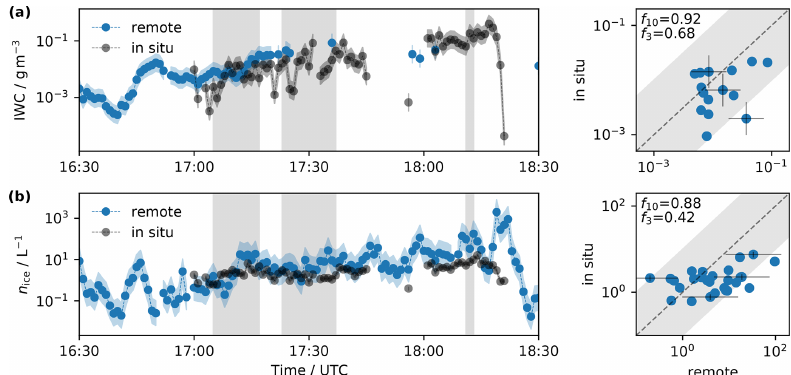
Figure 8. Comparison of the remotely retrieved and in situ measured (a) ice water content (IWC) and (b) ice crystal number concentration (ICNC, n ice as variable) on 8 March 2019. The IWC data were retrieved from the lowest size bin (1783ma . s . l . ). Due to measurement gaps, ICNC between 1900 and 2500ma . s . l . was averaged (median). Left: time series of available remotely retrieved data (blue) and in situ observed data (black). Right: scatter plot of data during times the balloon was at an elevation higher than 1750ma . s . l . (gray shading in the time series plots, maximal elevation: 1910ma . s . l . ). The gray shading in the scatter plots indicates an error of 1 order of magnitude. The values f 10 and f 3 indicate the fraction of data points within a factor of 10 and 3, respectively. Uncertainties are indicated by the shading for the time series and at representative data points of the scatter plots in